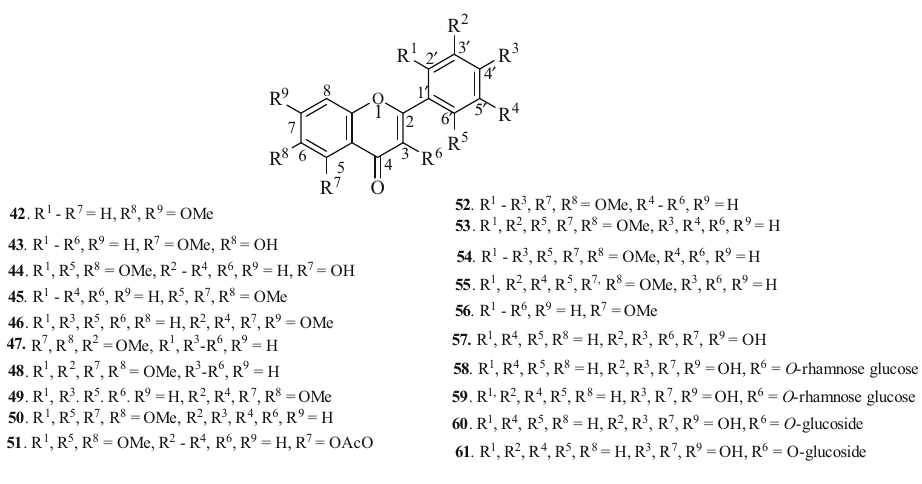
Figure 6: Structures of fl avonoids from genus Casimiroa .